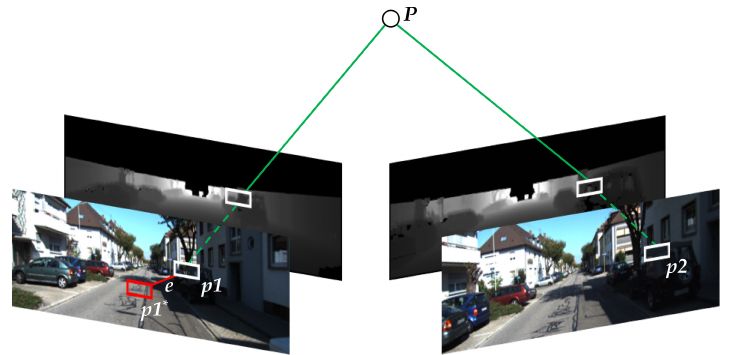
Figure 2. Schematic diagram of the reprojection